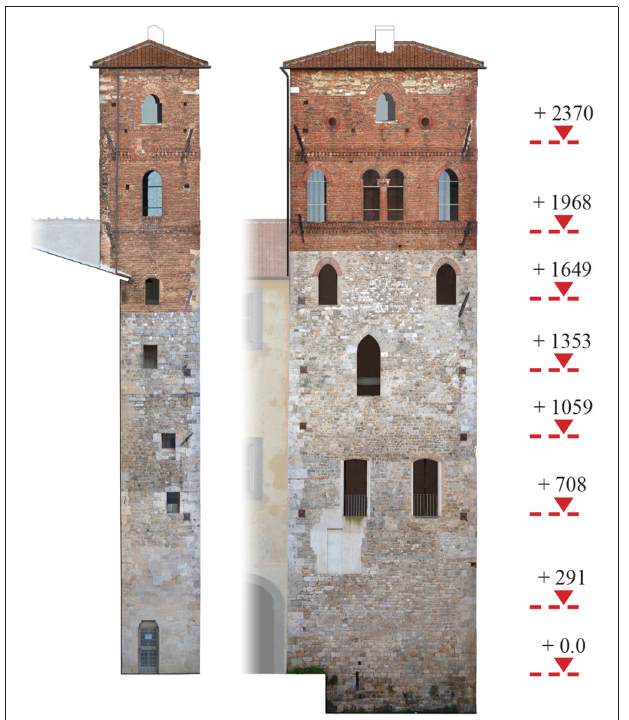
FIGURE 2 | Material analysis on the east and north façades of the Lanfreducci